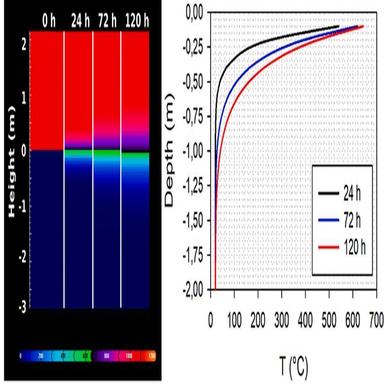
Results of Heat3D simulation. Left: Visual representation of soil heating by superimposition of a hot lava flow after 1, 3 and 5 days; in red the lava flow (starting T = 1070 ◦C), in blue the soil (starting T = 20 ◦C). For the simulation, the following values were assumed: i) specific heat and thermal conductivity of 1200 J/kgK and 1.8 W/mK, and 1150 J/kgK and 1 W/mK for the lava flow and the soil, respectively (; (ii) density of 2300 kg/m3 for the soil. Right: depth from the lava/soil contact v